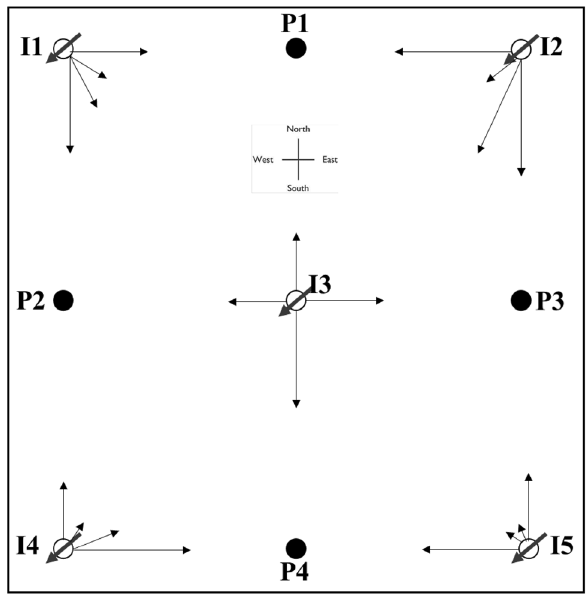
Fig. 6 Distribution of f ij in case I after applying D-CRMP. Each black arrow and its length represent the connectivity and magnitude, respectively